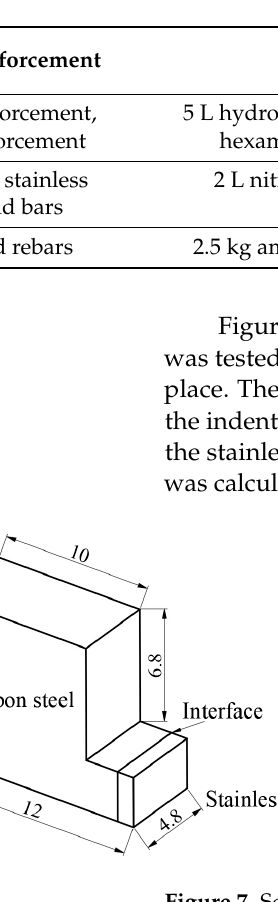
Table 3. Classification of solutions used to remove rust from reinforcement bars.